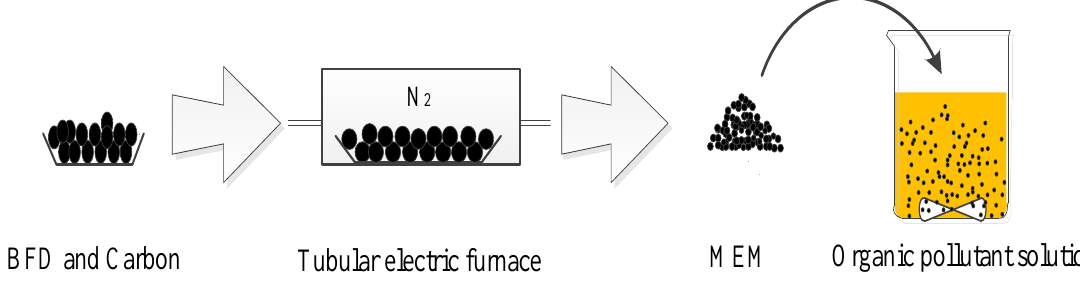
Figure 1. Diagram of micro-electrolysis process.